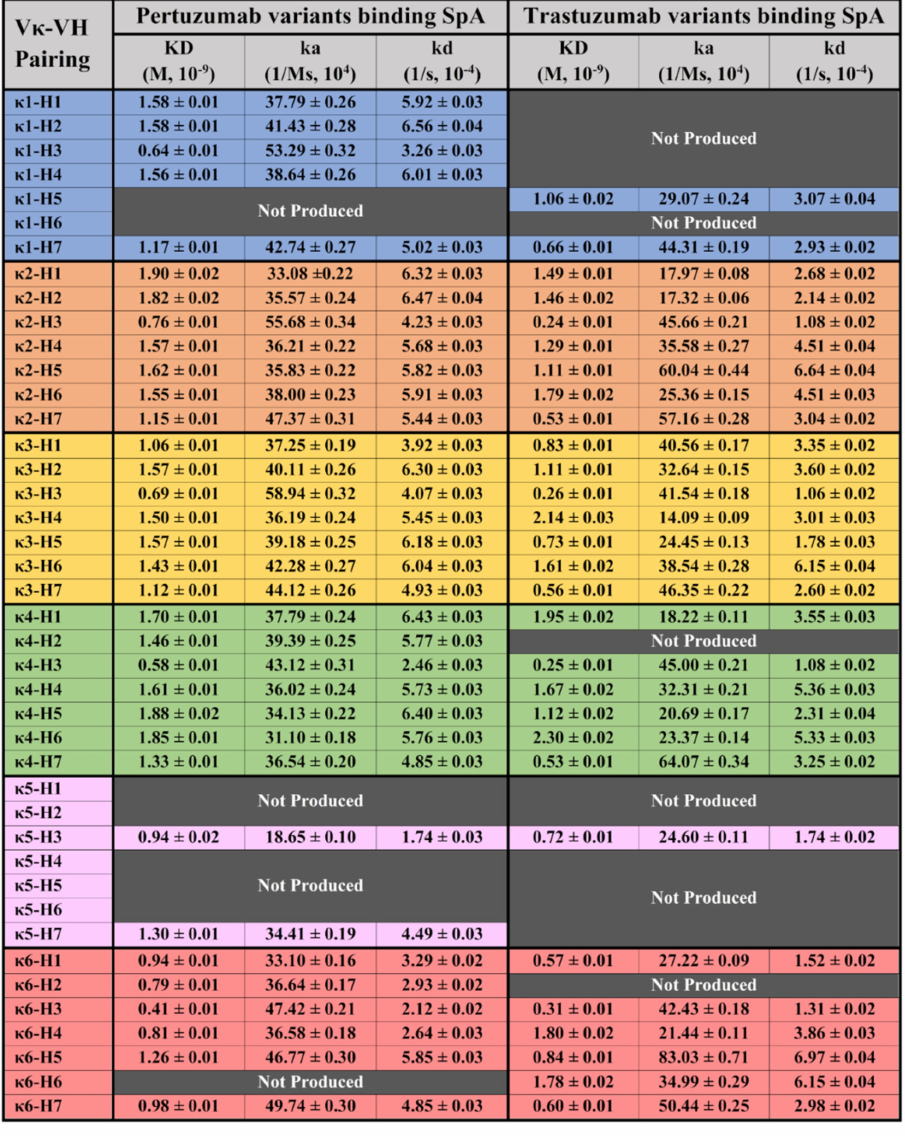
Figure 1. BLI measurements (KD, ka, and kd) of Pertuzumab and Trastuzumab V κ 1–6 and VH1– 7variants binding to the immobilised SpA biosensor. “Not Produced” denotes insufficient antibody production for the variant despite numerous large-scale transfections. All readings were obtained from at least three antibody concentrations. The readings were the average of independent triplicates. The graphs are shown in Supplementary Figures